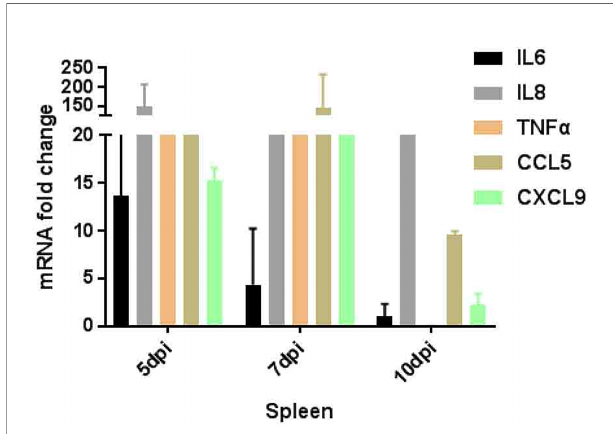
FIGURE 5 | In fl ammatory genes expression pattern in spleen of tree shrews infected ZIKV via